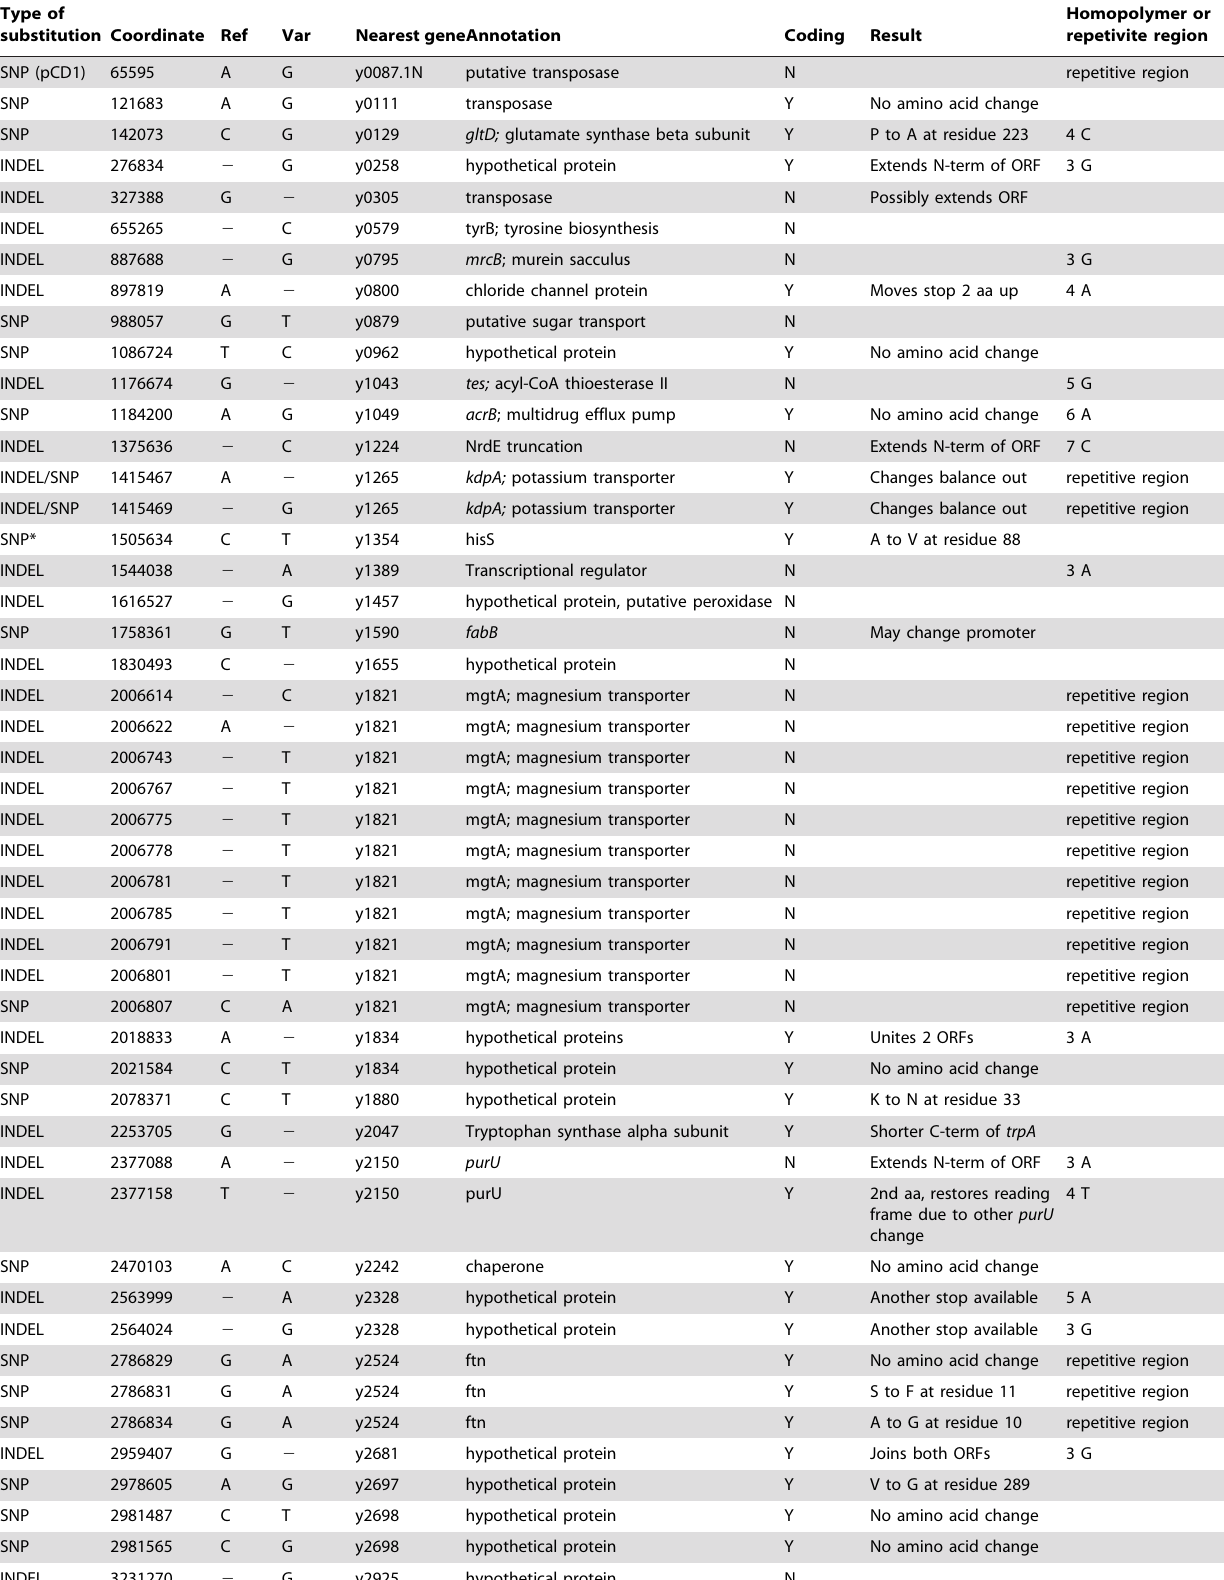
Type of substitution Coordinate